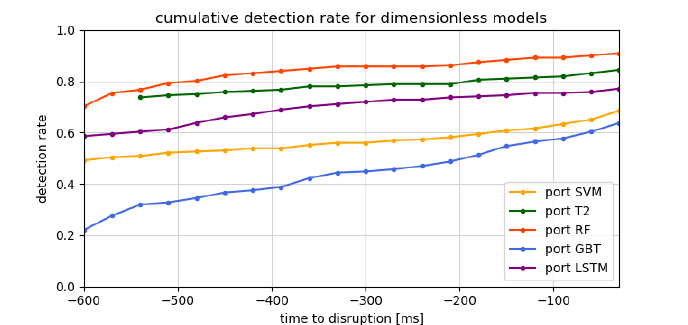
Figure 8. Cumulative detection rate for the different dimensionless predictor